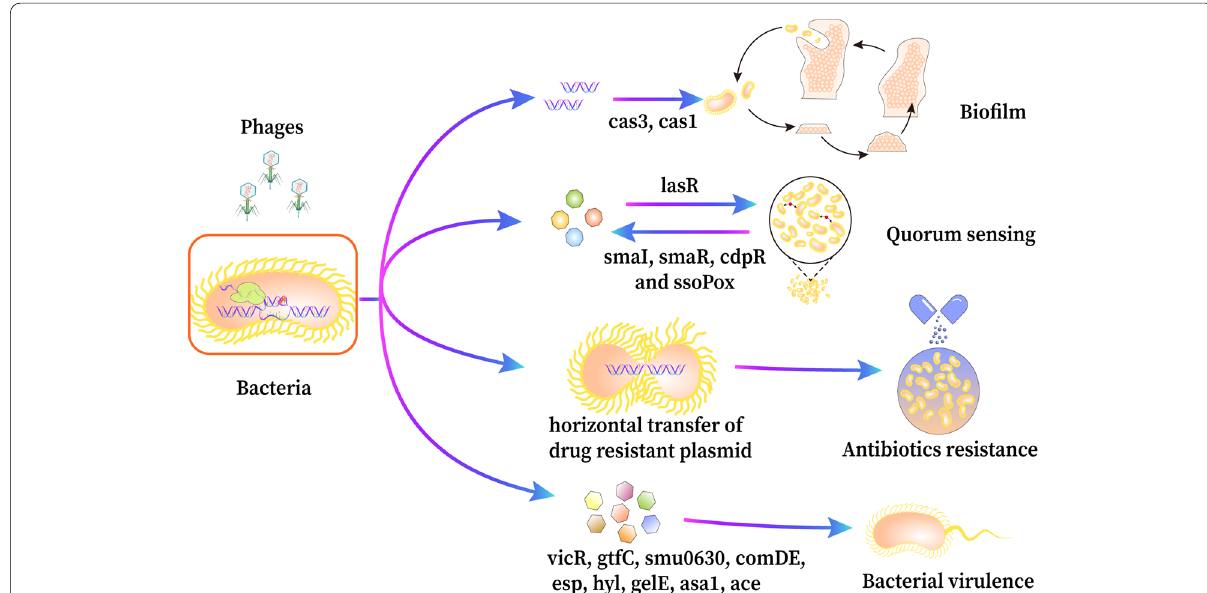
Fig. 2 Effect of CRISPR-Cas systems on physiological traits of bacteria. CRISPR-Cas systems affecting multiple bacterial characteristics, such as virulence, bacterial biofilm, QS and antibiotics resistance. CRISPR-Cas systems are associated with the expression of multiple virulence factors, such as vicR, gtfC, smu0630, comDE ( Streptococcus sanguinis ), esp, hyl, gelE, asa1, ace ( E. faecalis ). cas3 and cas1 genes directly or indirectly participate in and affect the formation of bacterial biofilm. There is mutual regulation between CRISPR-Cas systems and QS systems, and many genes are involved in this process, such as LasR, SmaI, SmaR cdpR, SsoPox and SmaR . CRISPR-Cas systems regulate the transfer of drug-resistant